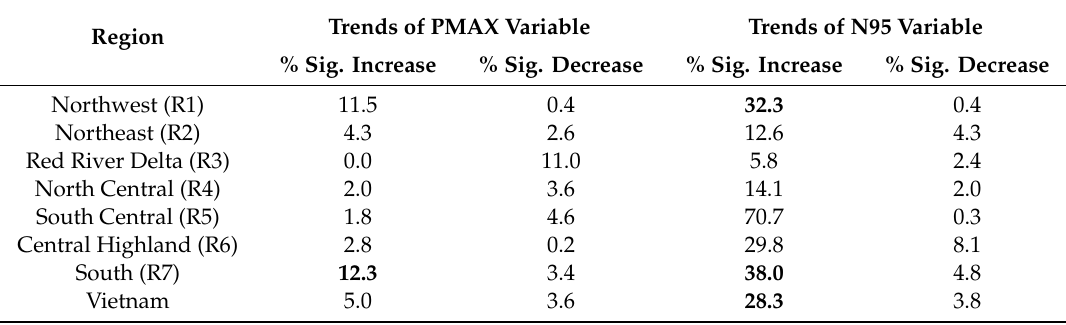
Table 1. The percentage of grid cells showing significant changes (at the 5% level) in the magnitude (PMAX variable) and the frequency (N95 variable) of precipitation extremes across seven climate regions. The results at the national scale are also shown (the last row). The field significance of increasing and decreasing trends is highlighted in